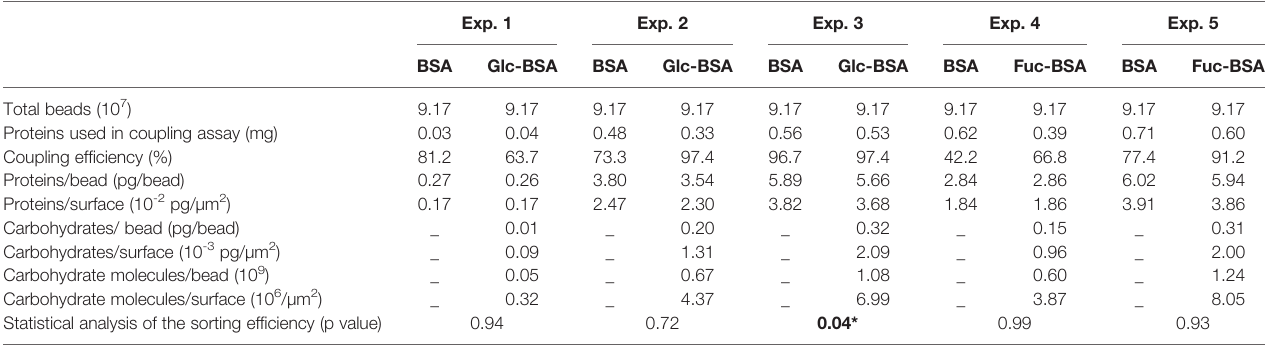
TABLE 1 | Parameters and outcomes of each of the 5 experiments. Microspheres (10 7 beads) were coated with different quantities of BSA (Bovin Serum Albumin, used as control) or one of neoglycoproteins, glucose-BSA (Glc-BSA) or fucose-BSA (Fuc-BSA). Exp. 1